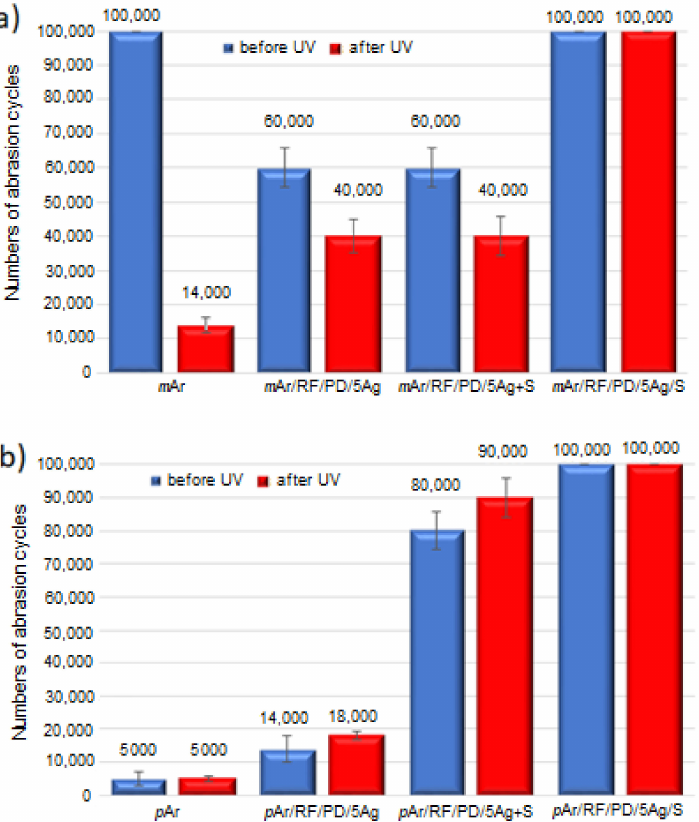
Figure 11. Results of the Martindale’s abrasion test for unmodified and modified m Ar ( a ) and p Ar ( b ) fabrics before and after UV irradiation (365 nm, 96